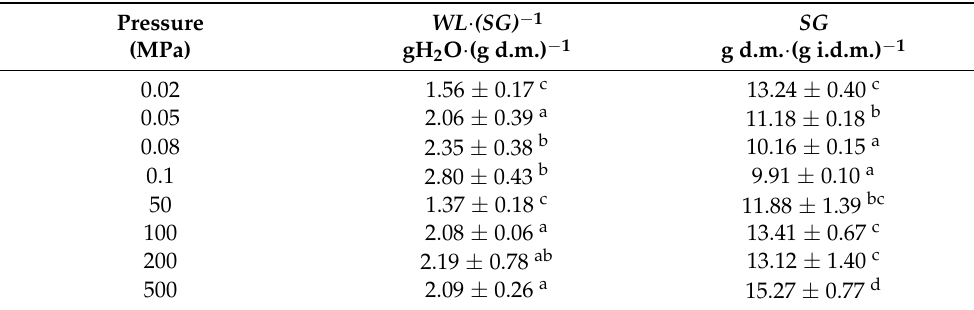
Figure 3. The course of the drying efficiency rate curves of apples initially osmotically dehydrated under varied pressure. It was shown that as a result of diffusive mass movement, water loss ( WL ) was greater than the increase in dry matter weight ( SG ) (Table 2). Table 2. Effectiveness of WL · ( SG ) − 1 osmotic dehydration of apples and increase in dry matter weight in fruit tissue under varied pressure. Mean values marked with the same letter index (a–d) do not differ statistically significantly at the level of p = 0.05.